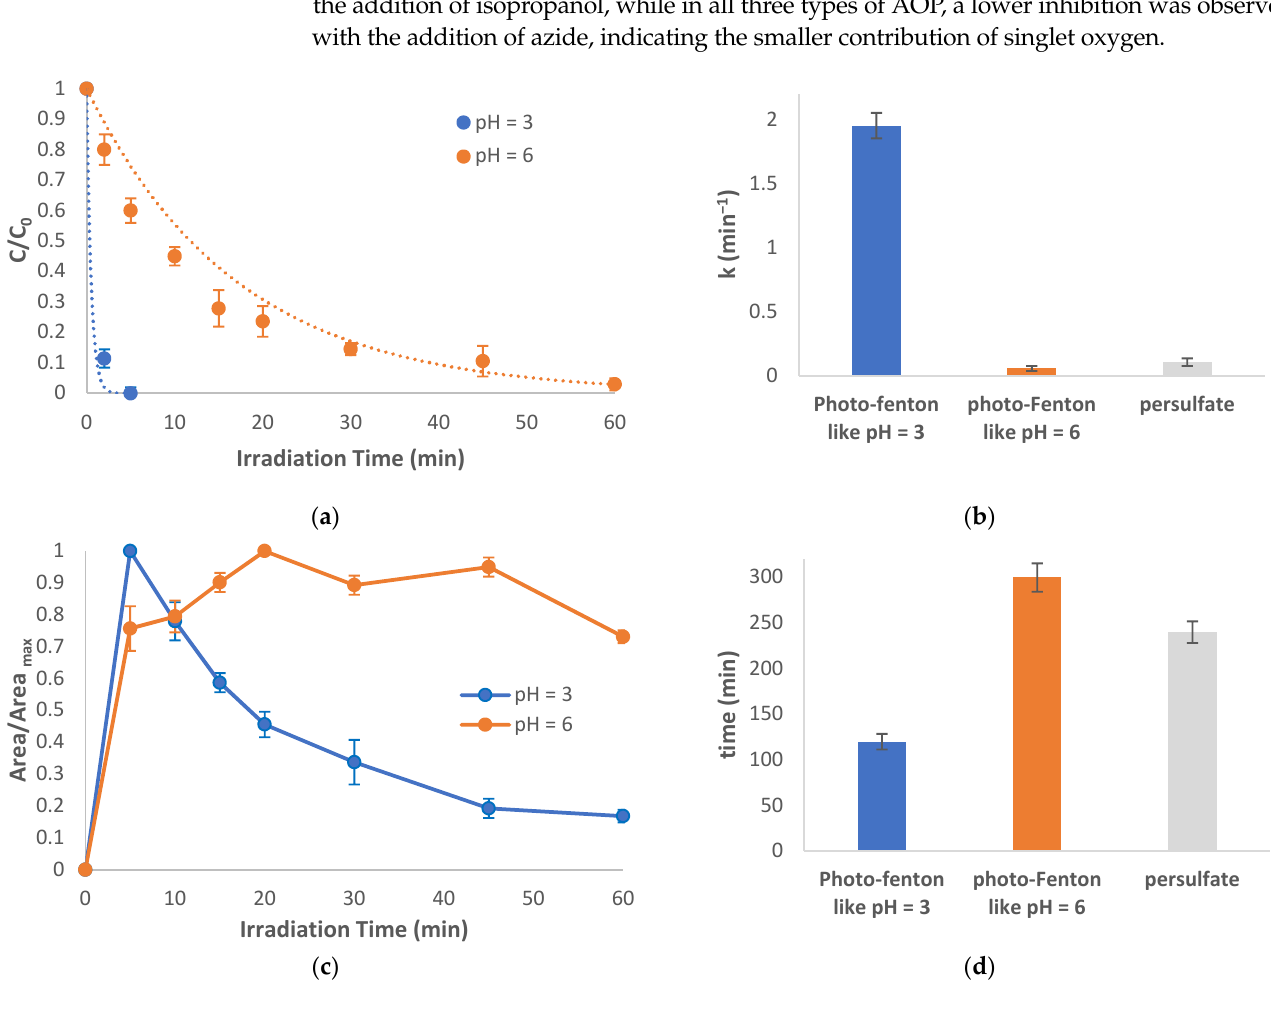
Figure 5. Photocatalytic treatment using a photo-Fenton-like reaction: ( a ) degradation of the parent compound at pH = 3 and 6, ( b ) rate constants of the degradation of abacavir, ( c ) evolution of TP-247, and ( d ) time required for complete disappearance of TP-247. C 0 = 10 mg/L, CFe 2+ =1 mg/L, C oxidant = 15 mg/L, matrix = ultrapure water.